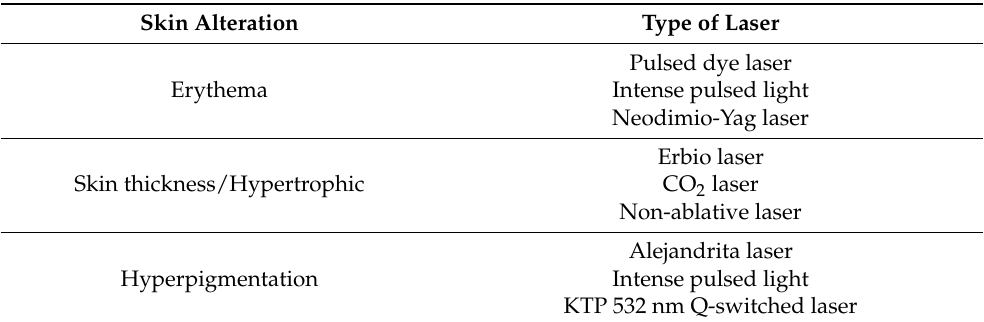
Table 4. Targeting lasers according to clinical exploration in hypertrophic scars and keloids. Skin